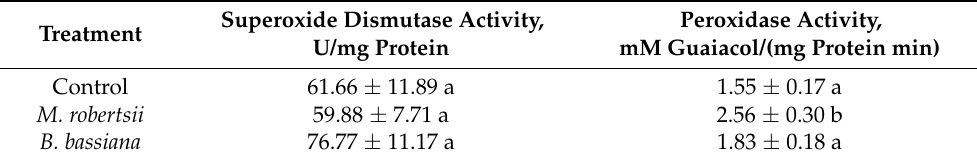
Table 4. Effect of treatment with EIPF on the activity of antioxidant enzymes in the leaves of Solanum tuberosum . Values are means ± SE (15–20 plants for each